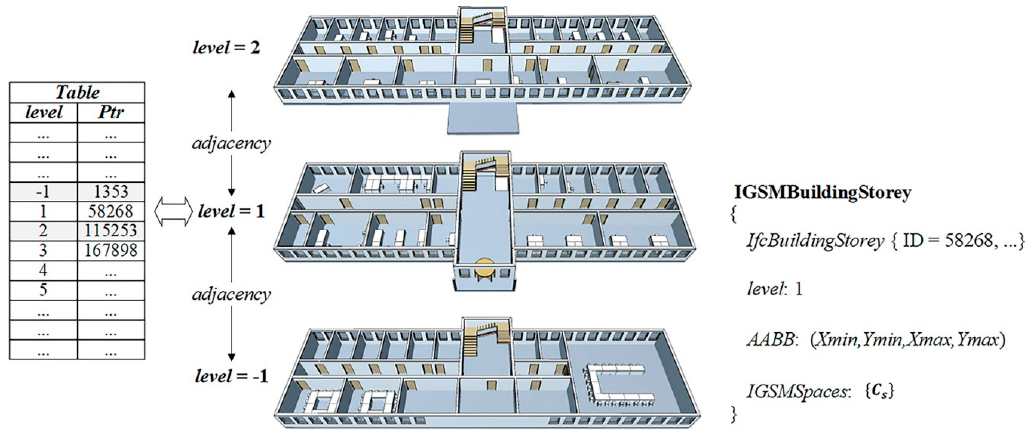
Figure 6. Diagram of IGSMBuildingStorey.